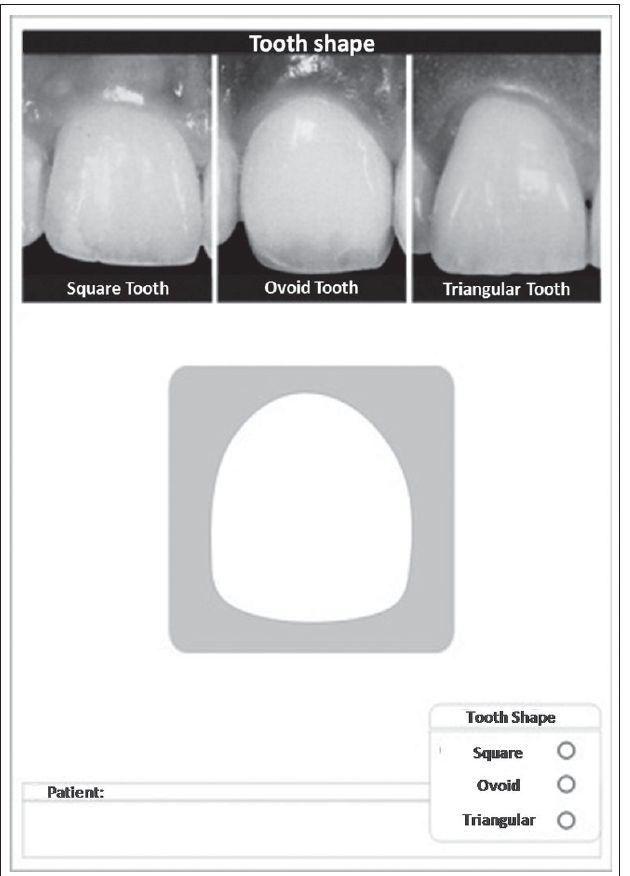
Fig. 4. A sheet from the album containing images of right maxillary dental incisor